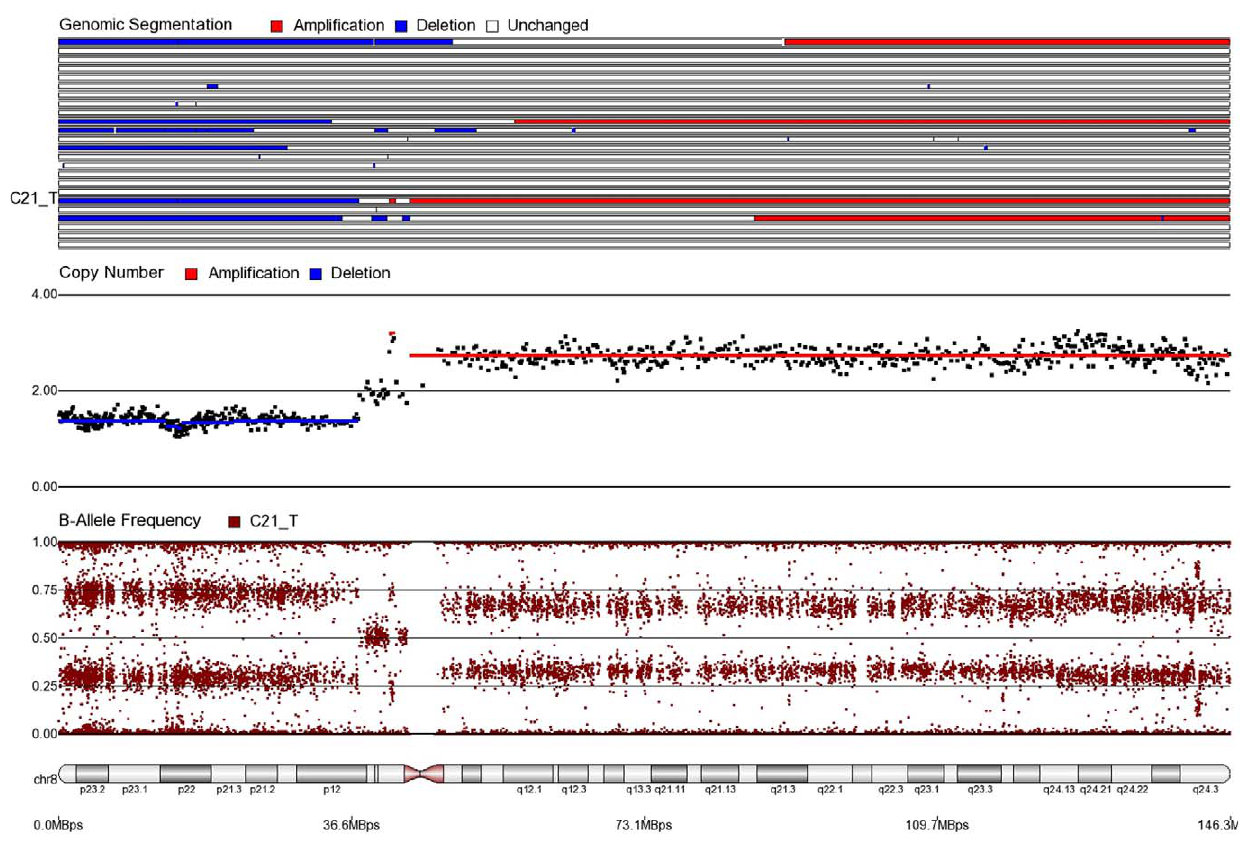
Figure 5. Mosaic monoallelic amplification and deletion in chromosome 8 for CRC tissue sample C21_T. In 8q (where BAF=0.38, 0.62 and CN=2.65), approximately 65% of cells have monoallelic amplifications (AAB or ABB). In 8p (where BAF=0.26, 0.74 and CN=1.35), approximately 65% of cells have monoallelic deletions (A_ or B_).